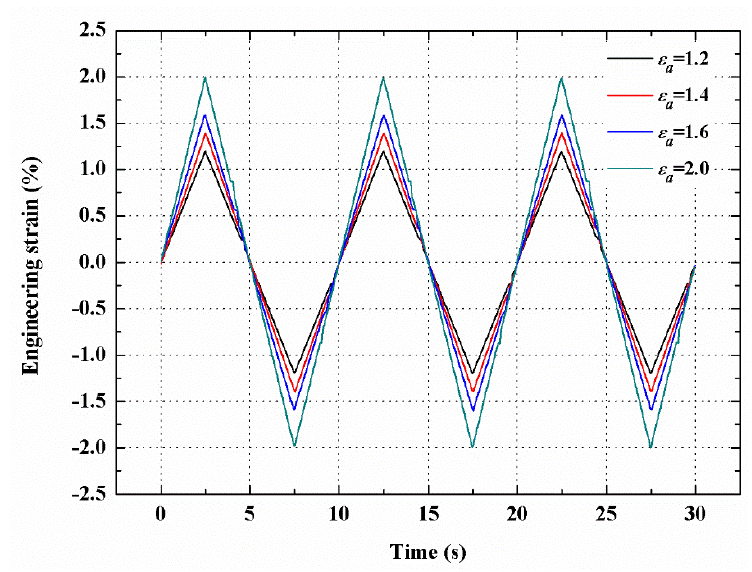
Figure 3. Strain–time waveforms of low cycle fatigue Figure 3. Strain – time waveforms of low cycle fatigue testing.